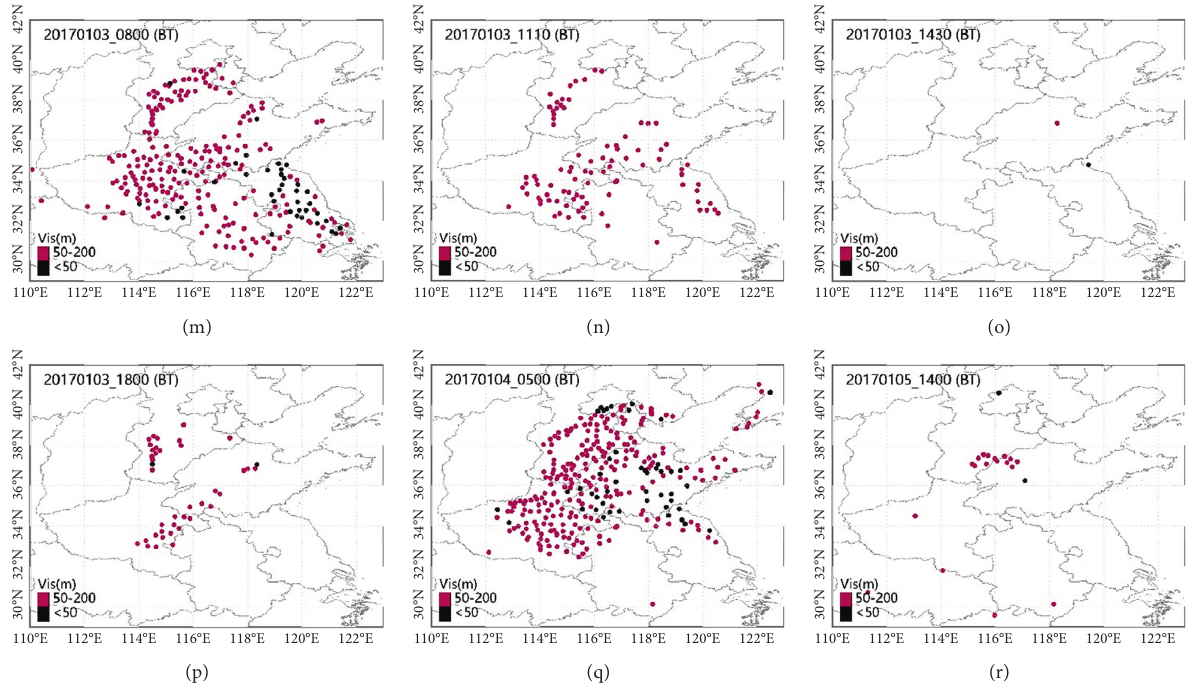
Figure 2: Evolution of wide range persistent SDF event from December 30, 2016, to January 5, 2017 (the red and black dots represent SDF and EDF stations, respectively). (a) 20161231_0200 (BT). (b) 20161231_0820 (BT). (c) 20161231_1410 (BT). (d) 20170101_0540 (BT).